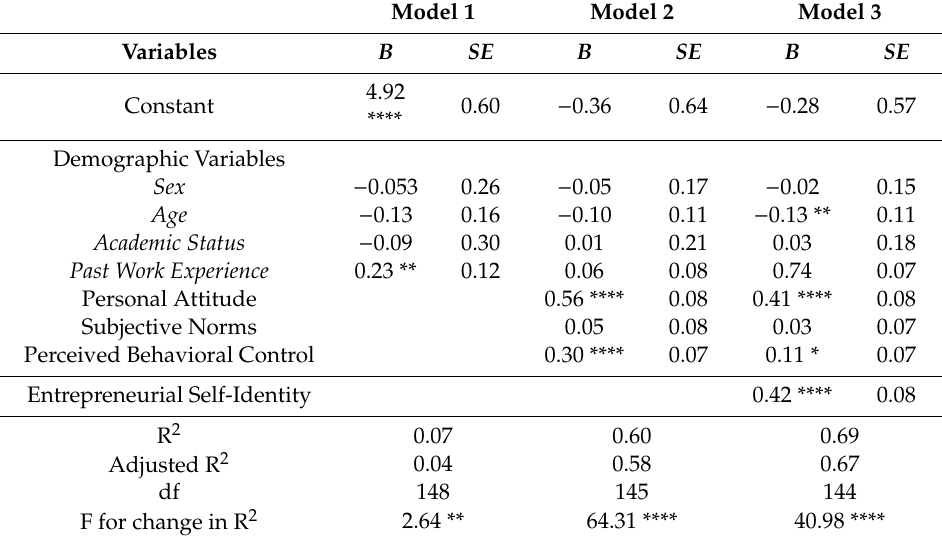
Table 2. Summary of hierarchical multiple regression analysis for variables predicting entrepreneurship intentions (N =